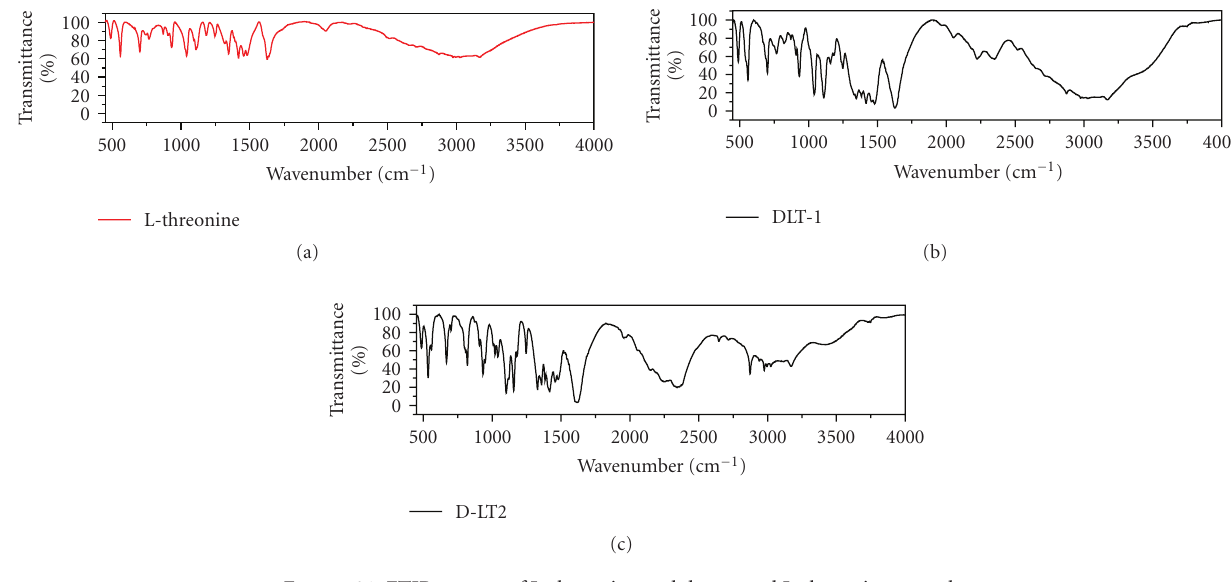
Figure 31: FTIR spectra of L-threonine and deuterated L-threonine crystals.